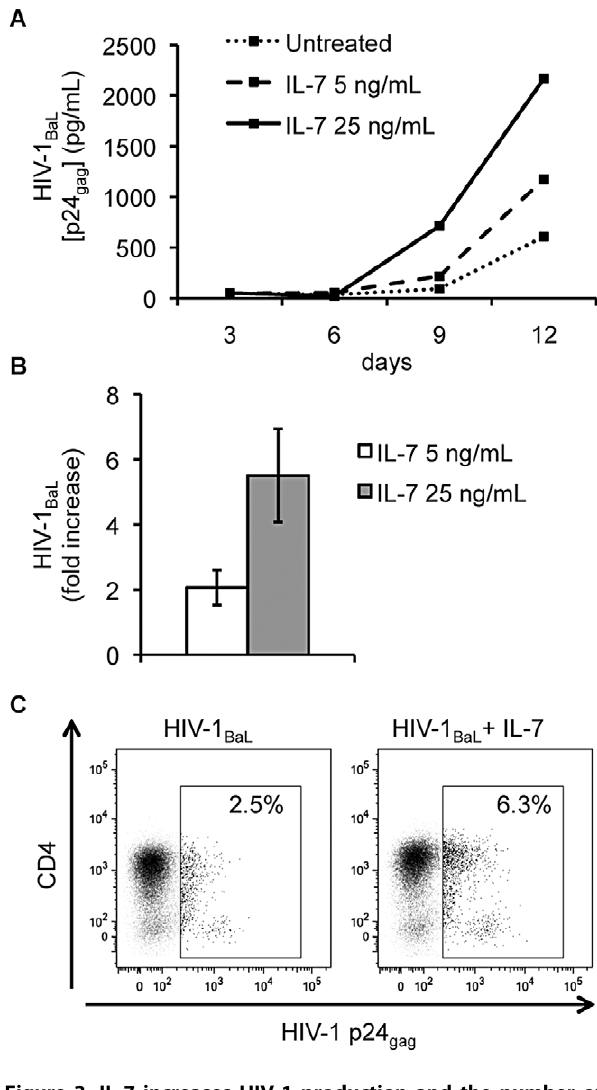
Figure 3. IL-7 increases HIV-1 production and the number of HIV-1-infected CD4 + T cells in cervico-vaginal tissue explants. Donor-matched cervico-vaginal tissue blocks were inoculated with HIV- 1 BaL and cultured for 12 days in the absence or presence of IL-7 5 or 25 ng/mL. ( A ) Presented are kinetics of the release of HIV-1 p24 gag in culture media of tissue blocks inoculated with HIV-1 BaL from a representative donor. Each point represents pooled viral release from 24 tissue blocks over 3-days periods. ( B ) Presented are the average increases in the cumulative release of HIV-1 p24 gag in culture media of tissue blocks infected with HIV-1 BaL and treated with IL-7 5 or 25 ng/mL compared with infected untreated donor-matched tissue blocks (means 6 s.e.m., n =5). ( C ) Presented are dot plots for CD4 + T cells isolated from HIV-1-infected tissue blocks treated or not treated with IL-7 25 ng/mL from a representative donor on day 9 post infection. The amount of HIV-1-infected CD4 + (CD8 2 p24 gag + ) T cells is expressed as percentage of total CD3 + CD8 2 cells.